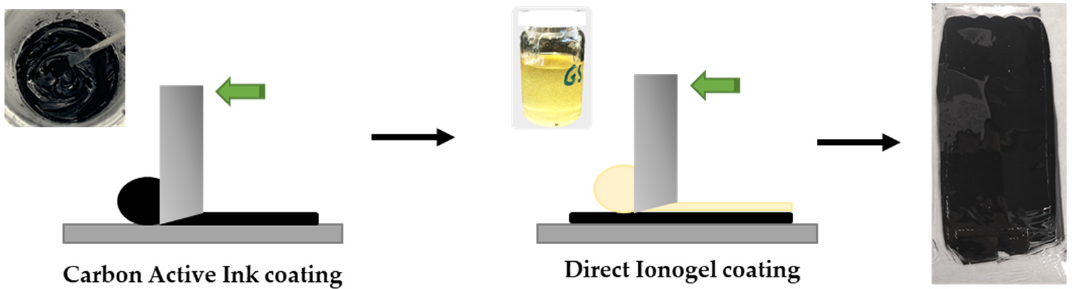
Figure 2. Direct printing process by Doctor Blade technique of the CNFc-ionogel onto the electrodes.